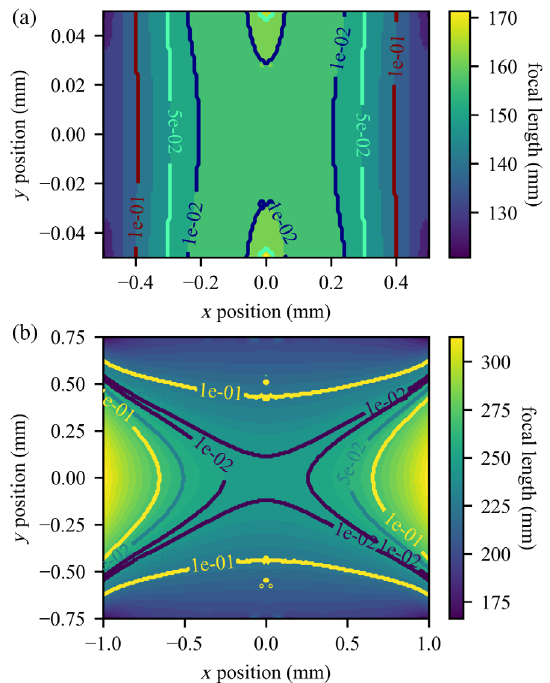
FIG. 5. Device focal length in millimeters at a beam energy of 3.2 MeV, showing aberrations in device with a current of 20 A ð J ¼ 2 × 10 8 A = m 2 Þ for the (a) small aperture (1 mm width, 0.1 mm gap) devices and (b) large aperture (2 mm wide, 1.5 mm gap) devices. The colormap shows the focal length across the device aperture, and the contour lines show the 1%, 5%, and 10% “ good focal length ”